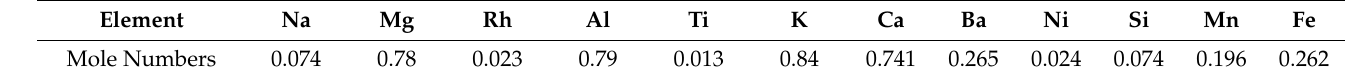
Table 1. Mole numbers of elements present in the waste used in the computer